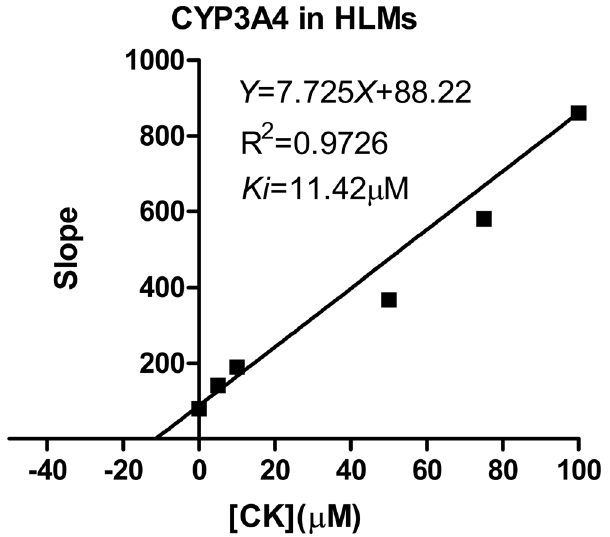
Fig 9. Secondary plot of CYP3A4 activity using the slopes of the primary Lineweaver – Burk plots versus concentrations of CK. Note: Nonlinear regression analysis of the CK versus the substrate concentration was performed to obtain the K i values. Each point represents the mean of triplicate